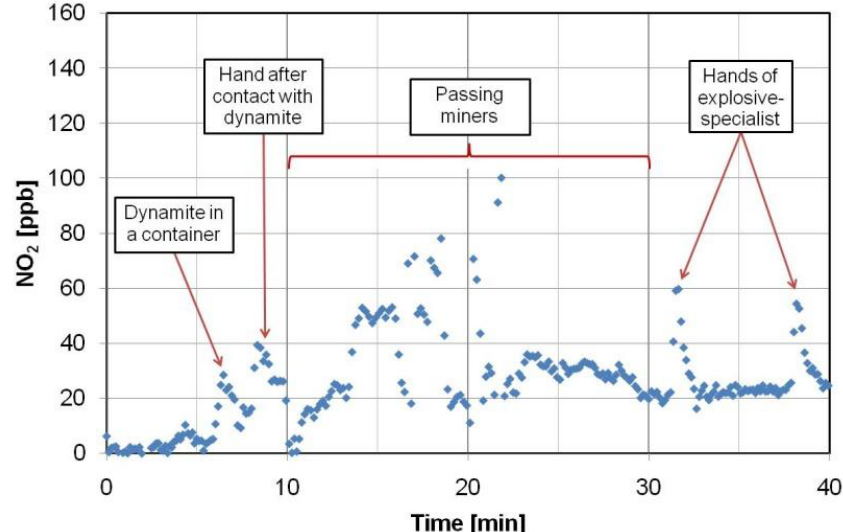
optoelectronic sensor in Polish mine 2